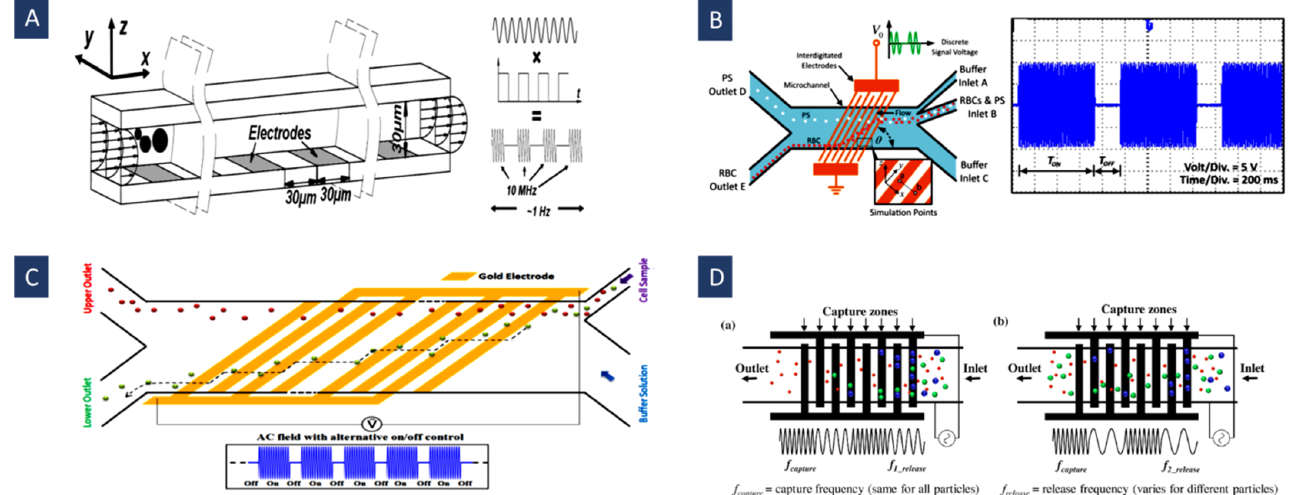
Figure 8. ( A ) Using puDEP for separation of intermediated size particles (Reprinted with permission from [107]. Copyright 2009, Royal Society of Chemistry); ( B ) separation of red blood cells (RBCs) and PS particles according to the difference in their dielectric properties using slanted electrodes (Reprinted with permission from [12]. Copyright 2020, John Wiley and Sons); ( C ) separating human mesenchymal stem cells (hMSC) and their differentiation progeny (osteoblasts) based on changes happening in the stem cells’ morphology and the structure of the membrane during their differentiation (Reprinted with permission from [71]. Copyright 2015, Royal Society of Chemistry); ( D ) using frequency hopping to separate different sizes of PS particles. ( a ) Capture mode. ( b ) release mode (Reprinted with permission from [72]. Copyright 2019, Elsevier).